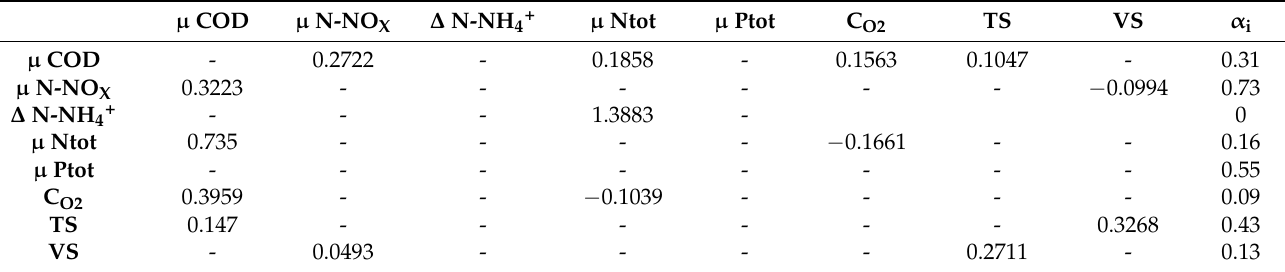
Table 3. Coefficients of multivariate linear regressions of yields and physical process parameters. Rows are indicative of the modeled parameters, while the columns represent coefficients of the model. α i , intercept value with ordinate